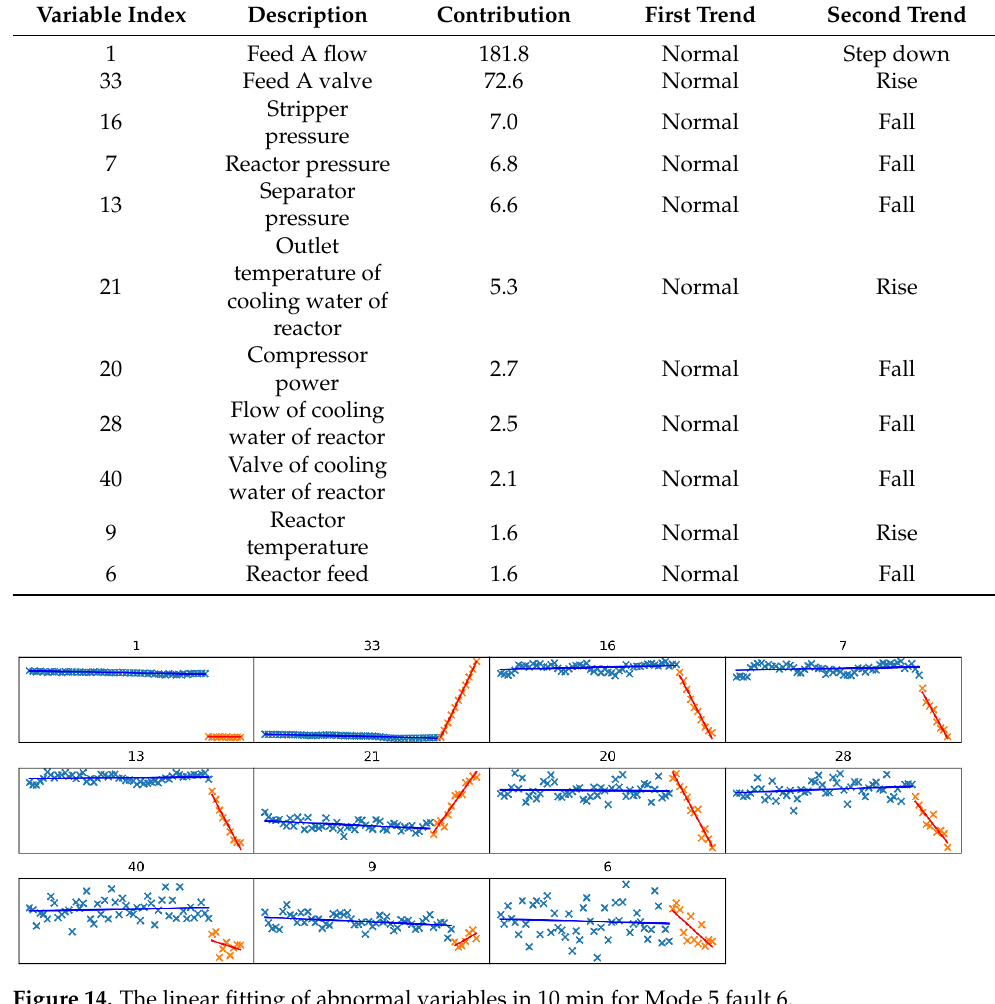
Table 8. The contributions of abnormal variables in 10 min after disturbance introduction.